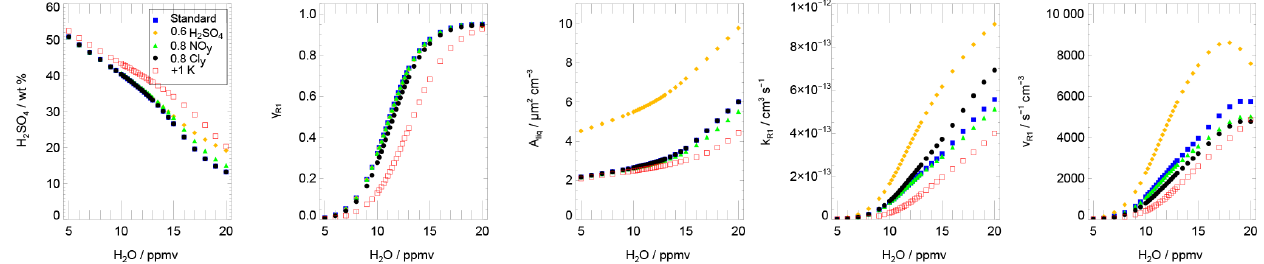
Figure 8. Dependence on water vapour of the rate of the main heterogeneous chlorine activation Reaction (R1) v R1 , the rate coefficient ( k R1 ), the y value γ R1 , the liquid surface area density A liq , and the H 2 SO 4 weight percent. Presented parameters correspond to the values after the first chemistry time step of the box-model simulation. Additionally the impact of an enhanced sulfate content (0.6ppbv H 2 SO 4 , yellow), reduced NO y (0.8 NO y , green), reduced Cl y (0.8 Cl y , black) and enhanced temperatures (red) is shown. The standard case is shown as blue